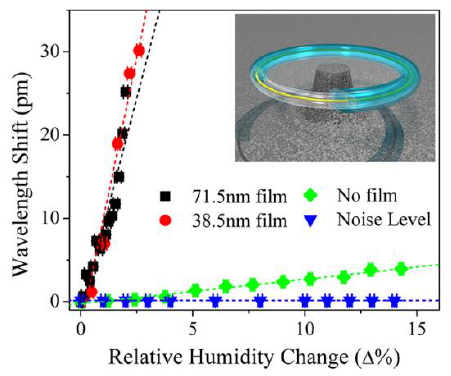
Figure 3. Resonant wavelength shift as a function of changes in the relative humidity at 23 °C for bare silica microtoroid, and pNIPAAm coated silica microtoroids (two different film thicknesses) as well as the noise level measurements. Addition of the pNIPAAm polymer coating improves the response of the bare silica device by nearly two orders of magnitude. The inset is a rendering image of the hybrid polymer coated silica microtoroid. Adapted with permission from reference [134] © 2013 American Physical